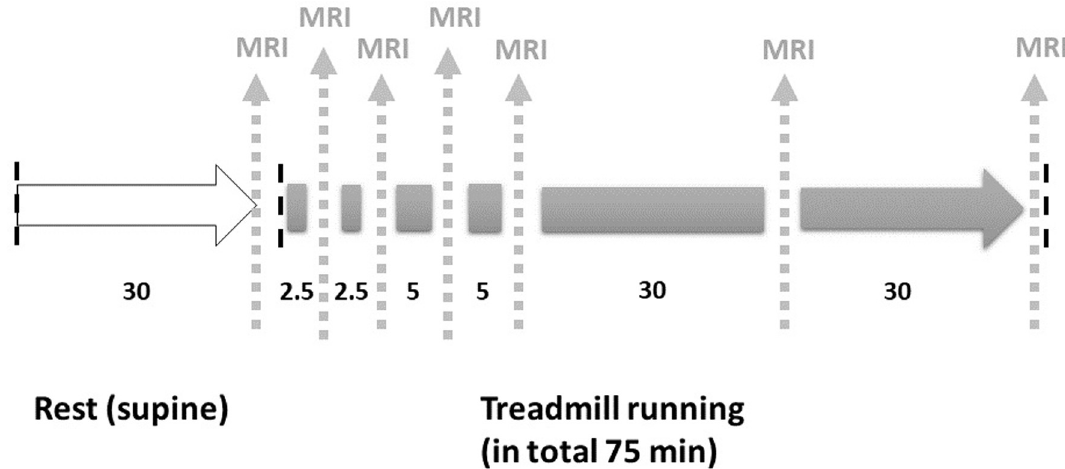
Fig 1. Schematic diagram of the scanning and running procedure. Vertical black broken lines indicate (from left to right) the start of the protocol, the onset of running and the end of running. Vertical grey broken lines indicate the interleaved